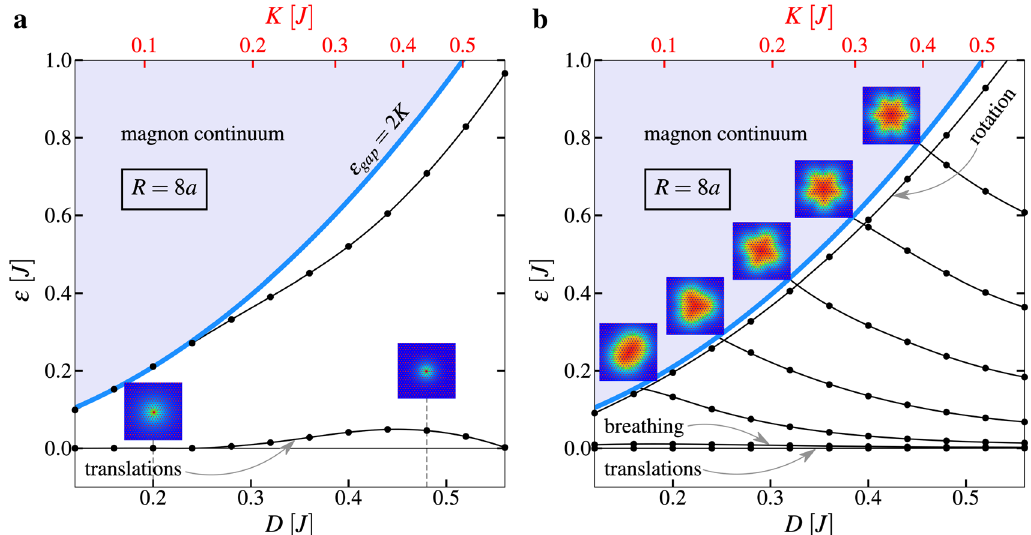
Fig. 4 Variation of the magnetic excitation spectrum at the transition state and at the skyrmion state along one of the contours of equal skyrmion radius. The spectrum is represented by the eigenvalues of the Hessian matrix calculated at the saddle point ( a ) and skyrmion state minimum ( b ). The calculated data corresponds to skyrmions with R = 8 a . Blue lines show the lower boundary of the continuous part of the spectra, ε gap = 2 K . Magnitude of the eigenvalues corresponding to the localized modes are shown with black solid lines. Filled circles indicate the calculated data points. The insets illustrate the saddle-point con fi gurations ( a ) as well as the skyrmion deformation modes ( b ). The color in the insets indicates the value of the out-of-plane component of the magnetic vectors (red ↔ up, blue ↔ down). Negative eigenvalue of the Hessian matrix at the SP is not shown in ( a